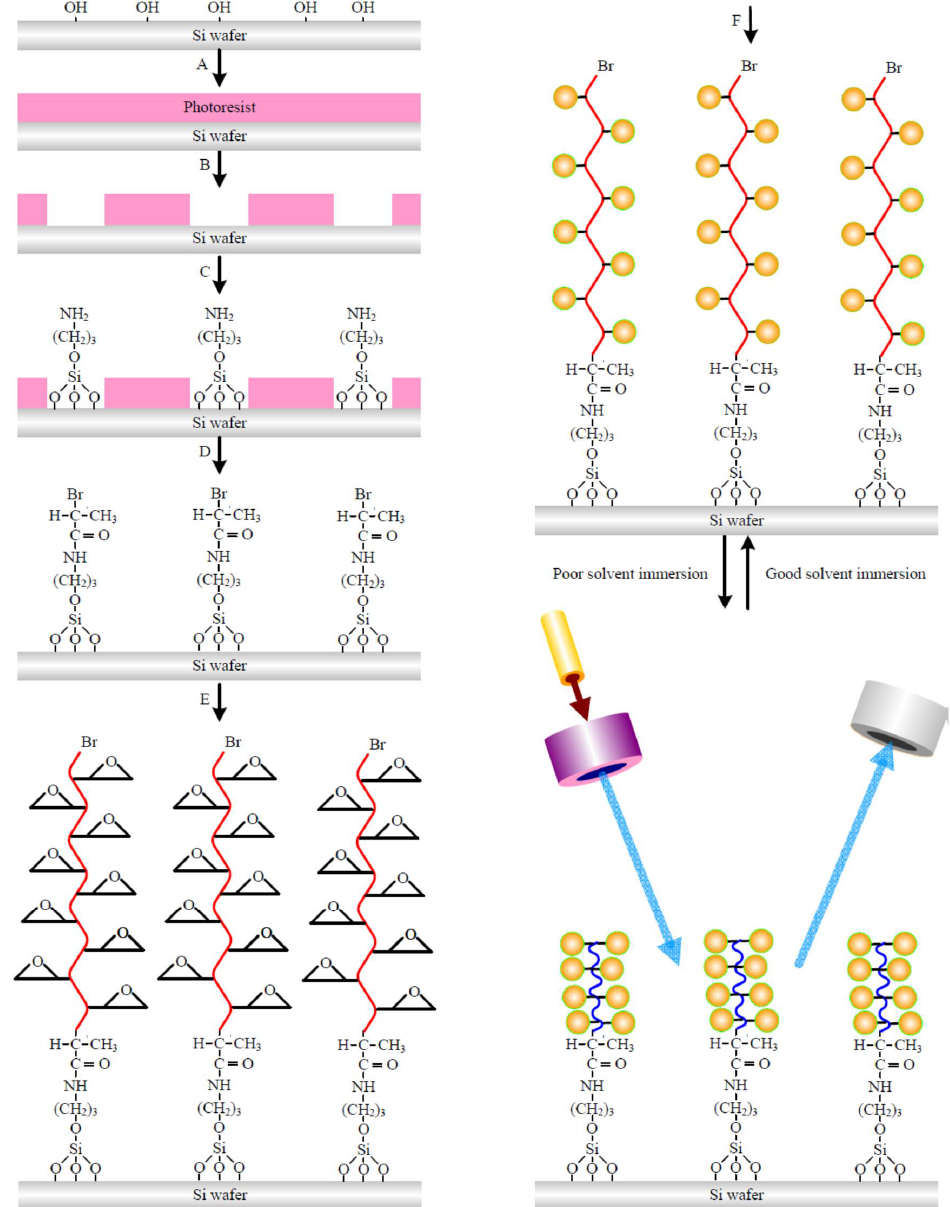
Figure 1. Schematic illustrations of the immobilization of CQDs on the 1DPPG. Si wafers were employed with HMDS in a thermal evaporator. Photoresist was spin coated onto the Si surface ( A ). I-line lithography was used to pattern the photoresist into trench arrays on the surface ( B ). AS selectively assembled on the regions of trench bottoms of Si surfaces ( C ). BB selectively reacted with AS-treated Si surface to form the initiator ( D ). The sample grafting through surface-initiated (ATRP) of GMA from the functionalized areas of the line patterns as 1DPPG ( E ). Immobilization of CQDs on the 1DPPG by covalent bonding exhibits solvent-responsive behavior on optical property ( F ).